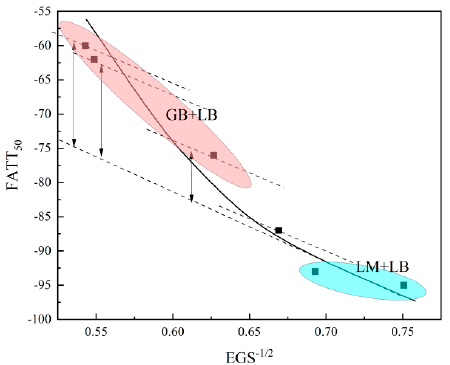
Figure 13. The correlation between the microstructure and FATT 50 . LM/LB fitted with the function of Hall–Petch (blue circle), and GB contributed to the rise of the FATT 50 (red circle).